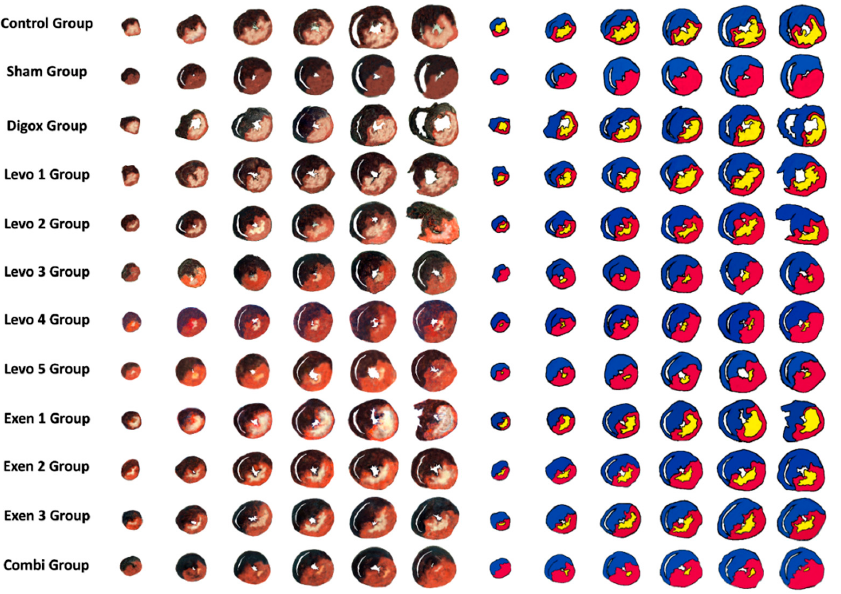
20 of 30 Figure 14. Changes in LDH across groups over time.